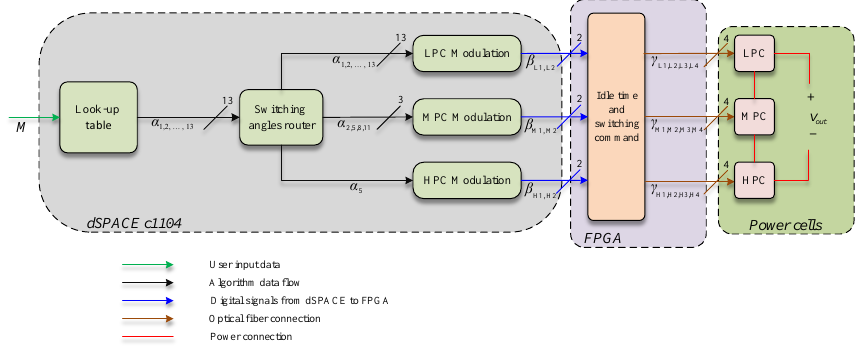
Figure 9. Control scheme for implementation.